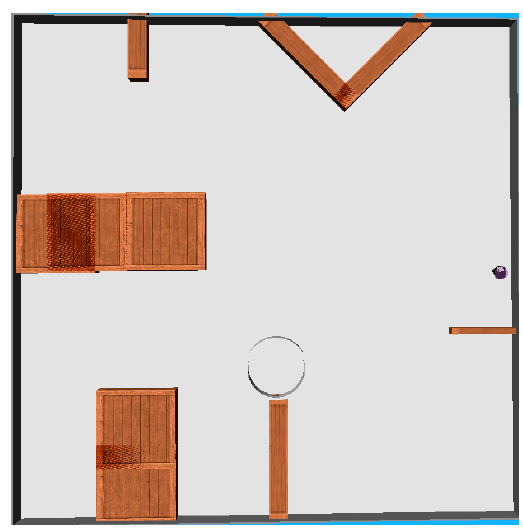
Figure 1. Training map used to learn fuzzy controllers (FCs).